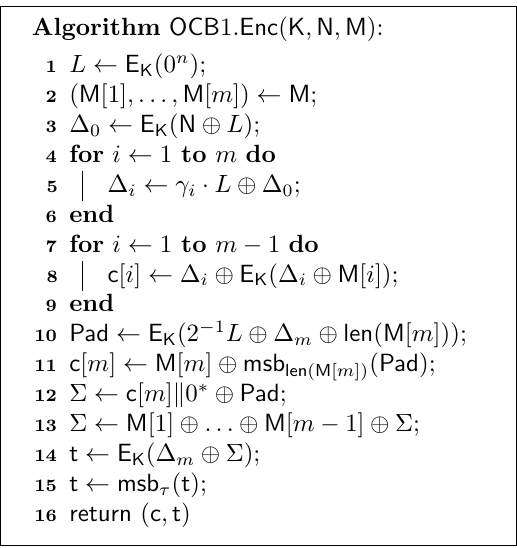
Figure 1: OCB1 block-cipher mode. Here γ i is the Gray encoding of integer i